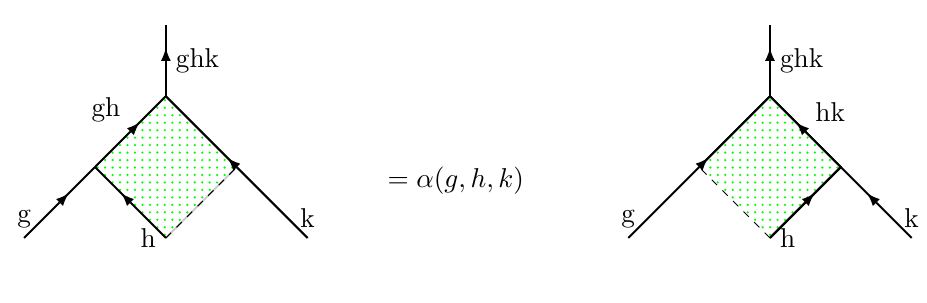
Figure 1 . Two different ways of fusing three defects L g , L h , and L k into a single defect L ghk through a sequence of 3 -pronged junctions. The dashed lines represent the identity defect, that we added for later convenience. One can continuously deform the left configuration into the right one; along this transformation, there is a point where the defects L to a single 4 -pronged junction. Passing across that point, a correlation function might get a non- trivial phase α ( g, h, k ) . Equivalently, the left and the right-hand side are related by a local gauge transformation acting by a group element h in the green region; this picture makes it clear that α ( g, h, k ) is a ’t Hooft anomaly — correlation functions pick up a non-trivial phase under gauge transformations of the background gauge